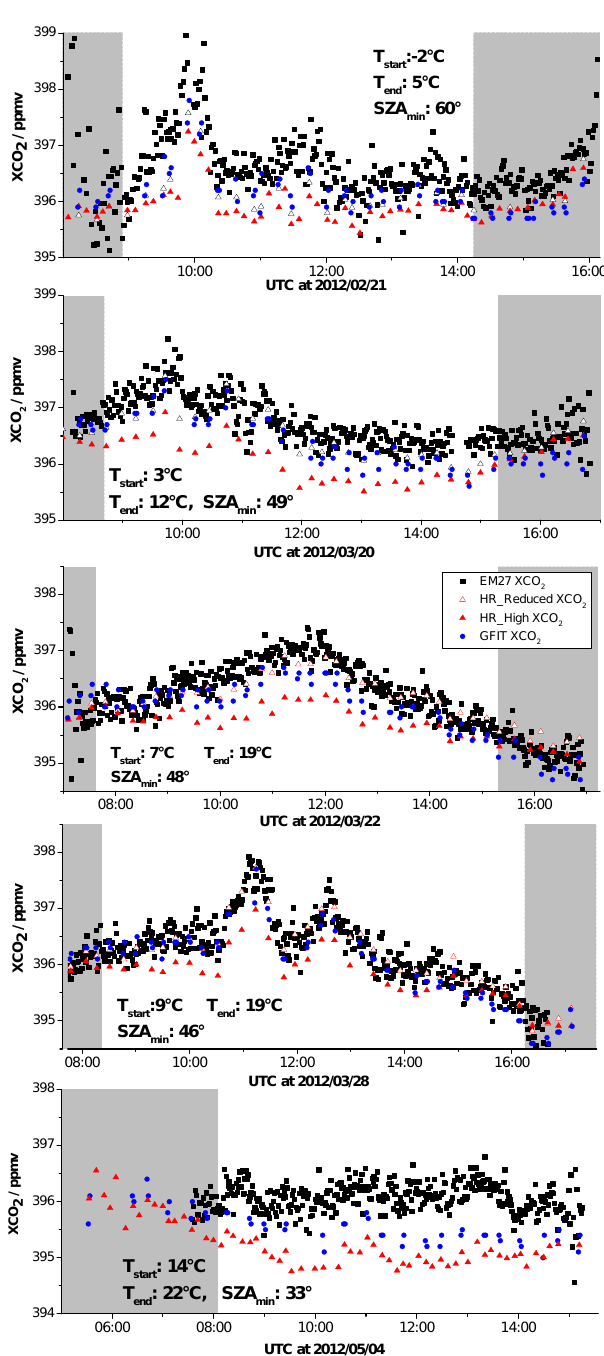
Fig. 8. Measurements of retrieved XCO 2 at 5 sample days. The number of interferograms and respective recording time contained in a single datapoint of each type are the same than in Fig.